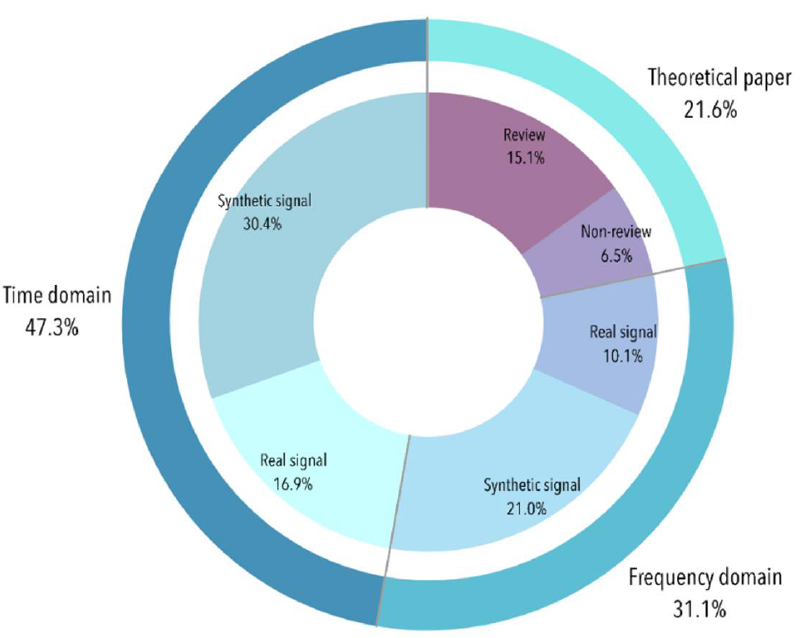
Figure 7. Double pie chart of types of papers depending on whether they are theoretical, in-time domain, or in-frequency domain.